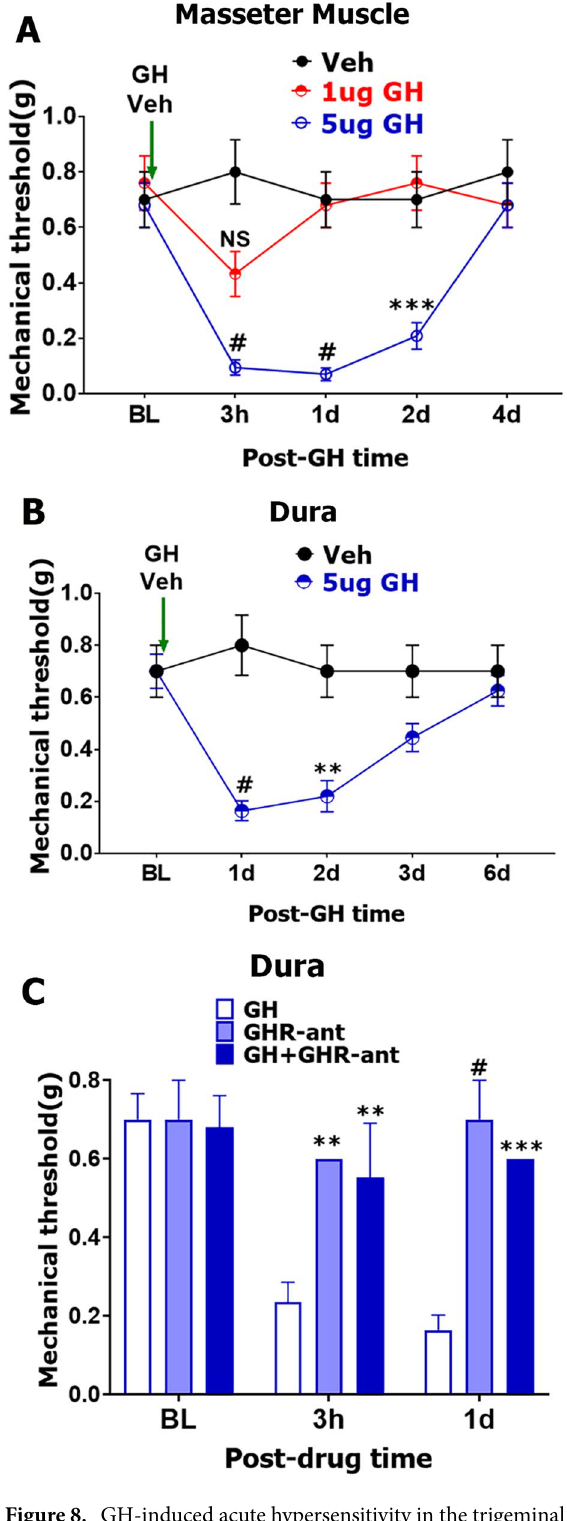
Figure 8. GH-induced acute hypersensitivity in the trigeminal system. ( A ) Orofacial mechanical nociception after intra masseter muscle administration of GH or vehicle. N = 4–5 ( B ) Periorbital mechanical nociception after dura matter administration of GH (5 μg) or vehicle. N = 5–6. ( C ) Periorbital mechanical nociception at 3 h and 1d after dura matter administration of GH (5 μg), GH receptor antagonist (GHR-ant; 25 μm) or a mix of GH (5 μg) and GHR-ant (25 μg). N = 4–8. Statistic is 2-way ANOVA, Sidak’s post hoc test (NS—non-significant; ** p < 0.01; *** p < 0.001; # p < 0.0001). Dosages of GH are specified on some panels. Vehicle or GH a single administration time point is indicated on A and B panels with the green vertical